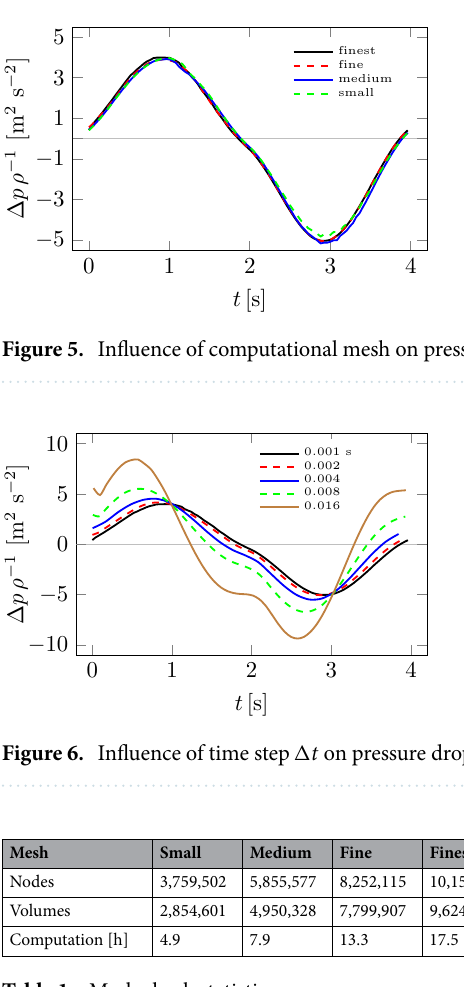
Table 1. Mesh check